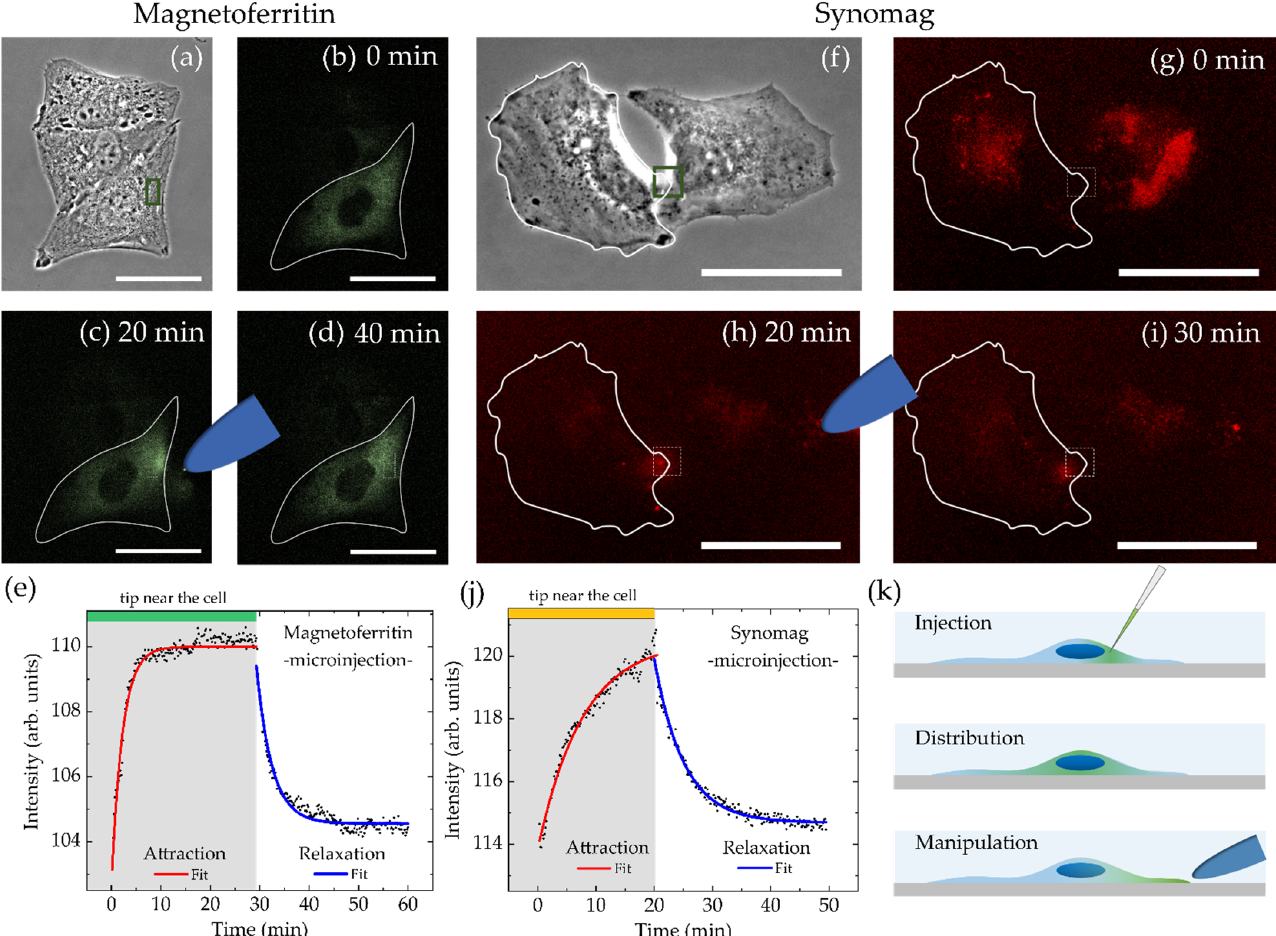
Figure 6. Spatial manipulation of ( a – d ) magnetoferritin and ( f – i ) synomag nanoparticles dispersed inside cytoplasm of living HeLa WT cells after microinjection recorded over 40 min. Scale bars are 50 µm. ( e , j ) show corresponding mean intensities over time with fit functions to characterize nanoparticle accumulation near the magnetic tip (green box in ( a , f )) and relaxation after tip removal. Distance between magnetic tip and analyzed region was (MFt) 6 µm or (synomag) 75 µm, respectively. ( k ) illustrates the experimental setup for microinjection.